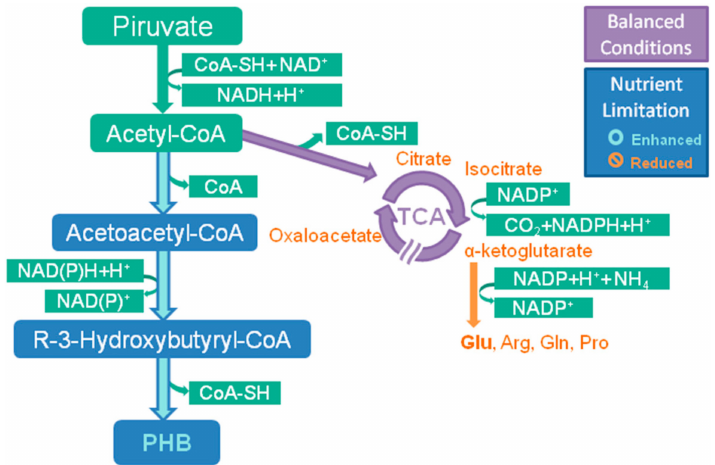
Figure 3. Carbon flow under balanced culture conditions, in purple, showing flux towards tricarboxylic acid cycle and under nutritional stress due to nitrogen and / or phosphorus limitation, enhanced flux or accumulation in blue and reduced activity in orange, with the carbon flux being directed to PHB